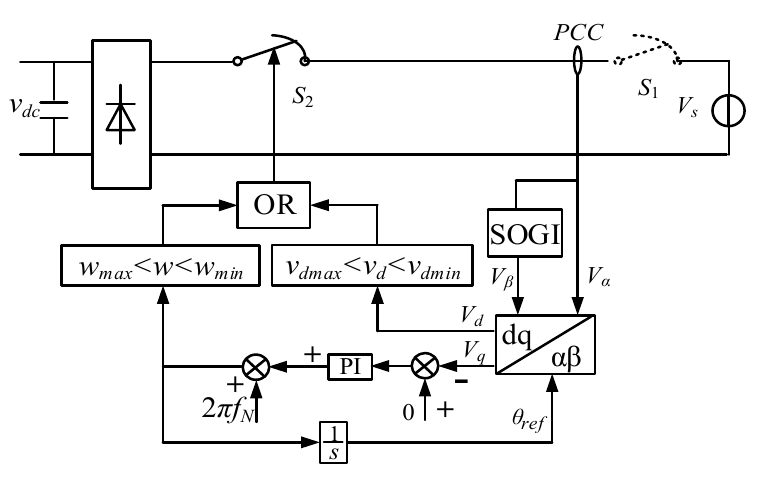
Figure 11. Island detection control block diagram.